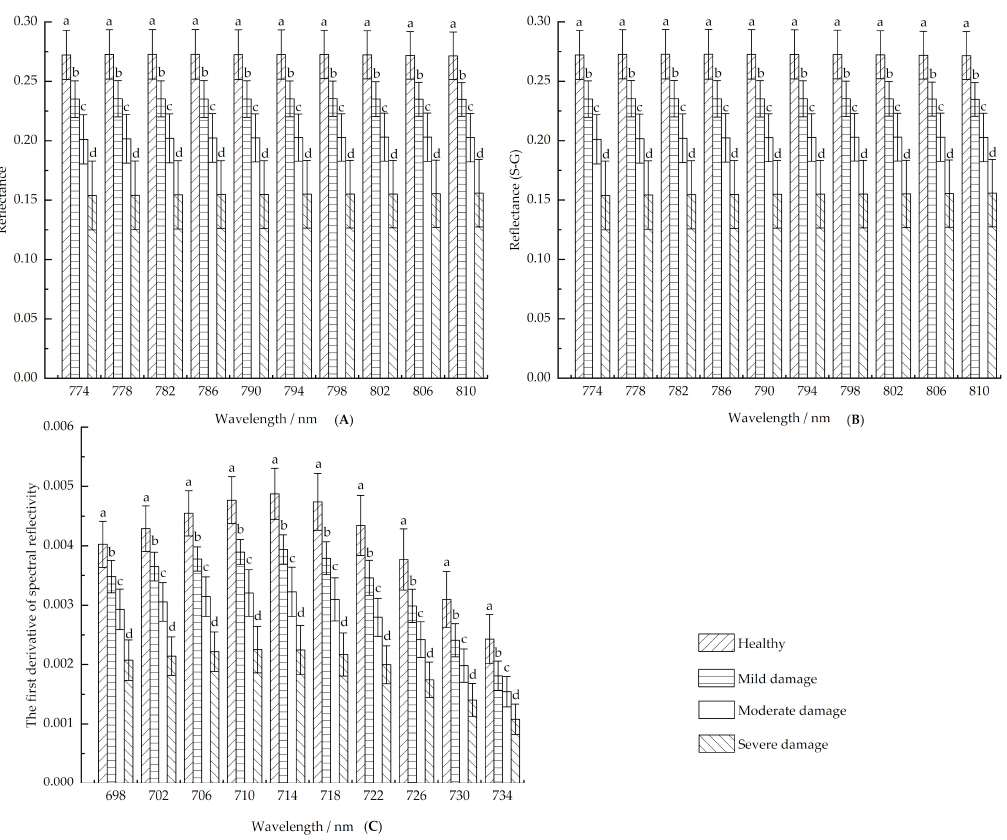
Table 7. Discriminant analysis results of different spectral processing methods.